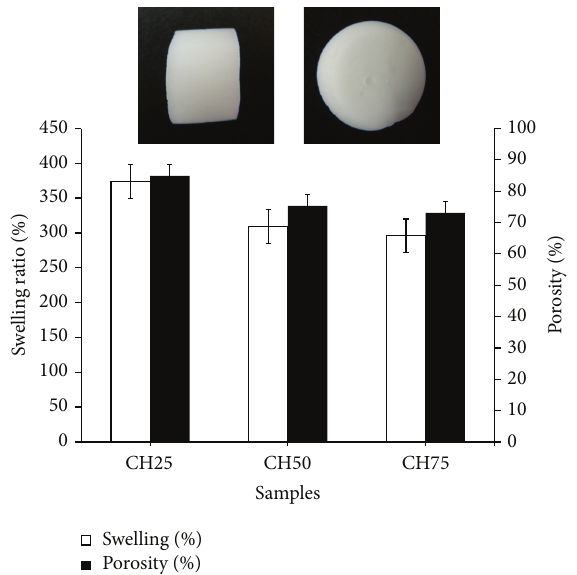
Figure 3: Porosity and swelling ratio of various grafted PVA-g- chitosan 3D scaffolds. The above histogram is the actual forming figure of the grafted PVA-g-chitosan 3D scaffold.